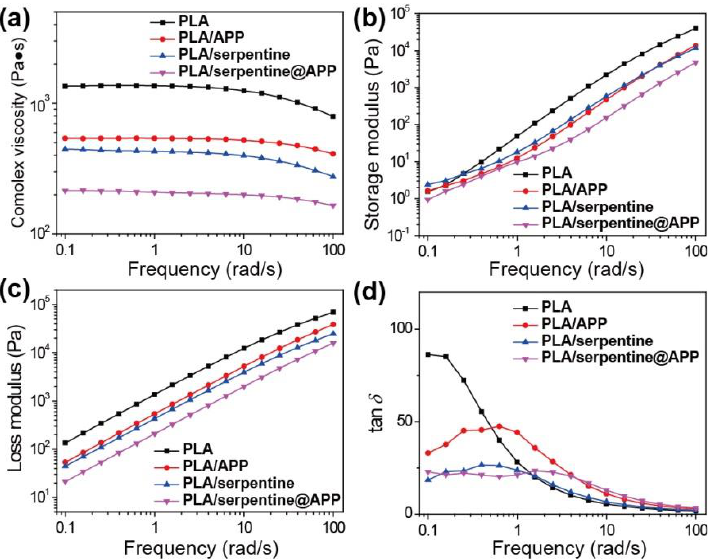
Figure 10. Dynamical frequency sweep of PLA composites. ( a ) complex viscosity, ( b ) storage modulus, ( c ) loss modulus, and ( d ) loss factor.